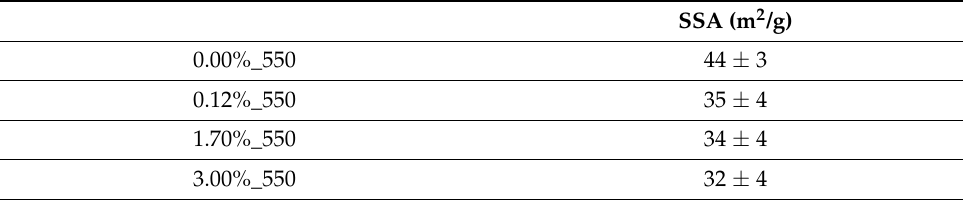
Table 1. Specific surface areas of the HSs calcined at 550 ◦